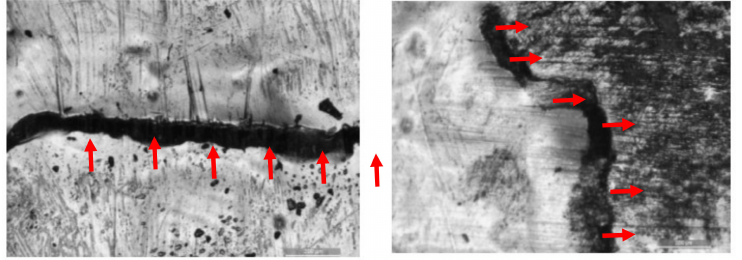
Figure 6. Optical images of the front faces of panels 13 ( left-hand side ) and 15 ( right-hand side ) detailing the matrix cracks perpendicular to the fibre direction (crack highlighted with red arrows).